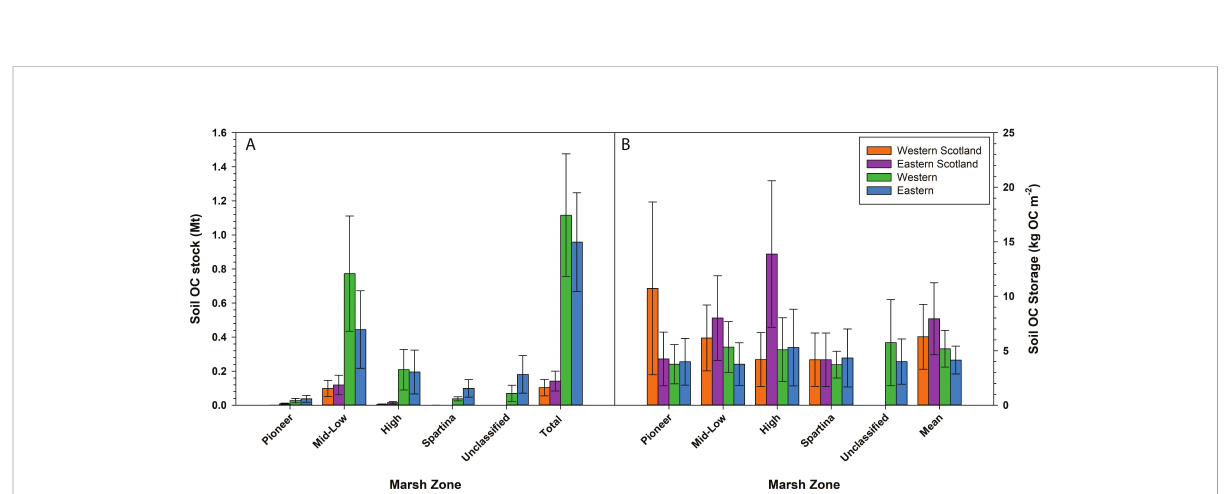
FIGURE 6 Saltmarsh sur fi cial soil (A) OC stocks (Mt) and (B) soil OC storage (kg OC m -2 ) for the different saltmarsh zones within the four geo-regions of Great Britain. Error bars represent 1 s . Full statistical breakdown of the OC stocks can be found in Supplementary Tables 6-10.